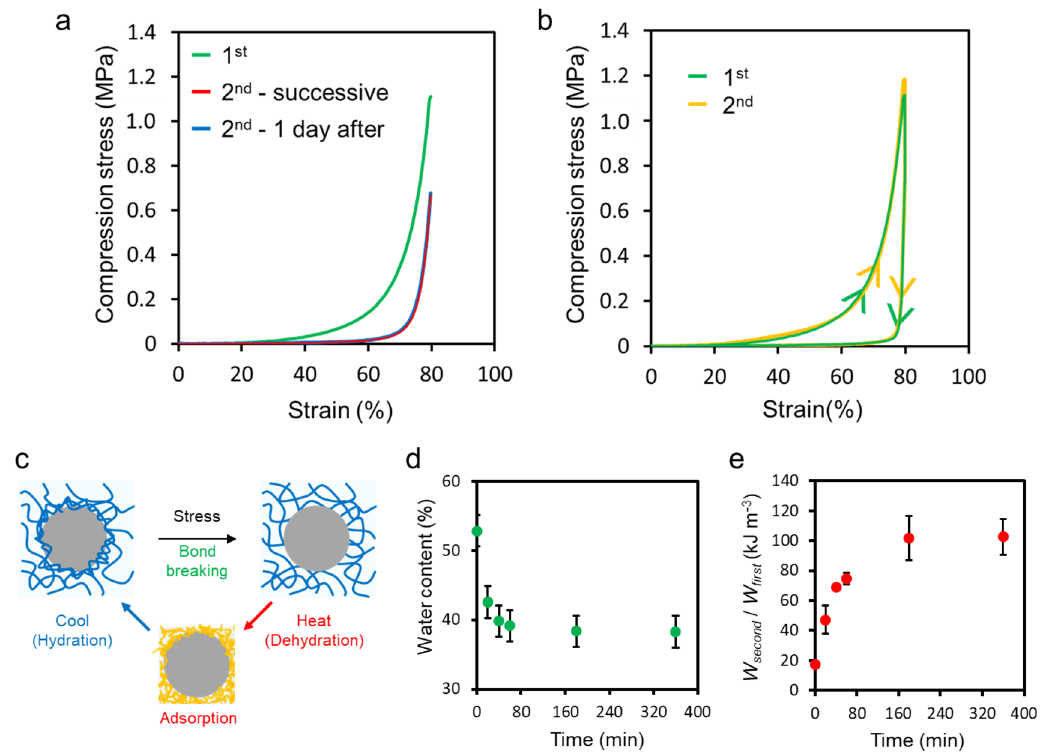
Figure 3. Stress–strain curves of composite gels for 1st and 2nd compression ( a ) before and ( b ) after heating– cooling process. ( c ) Reversible adsorption of polymer chain on the particle surfaces by applying a stress and shrinking process. ( d ) Water content and ( e ) recovery of dissipative energy as a function of incubation time at 50